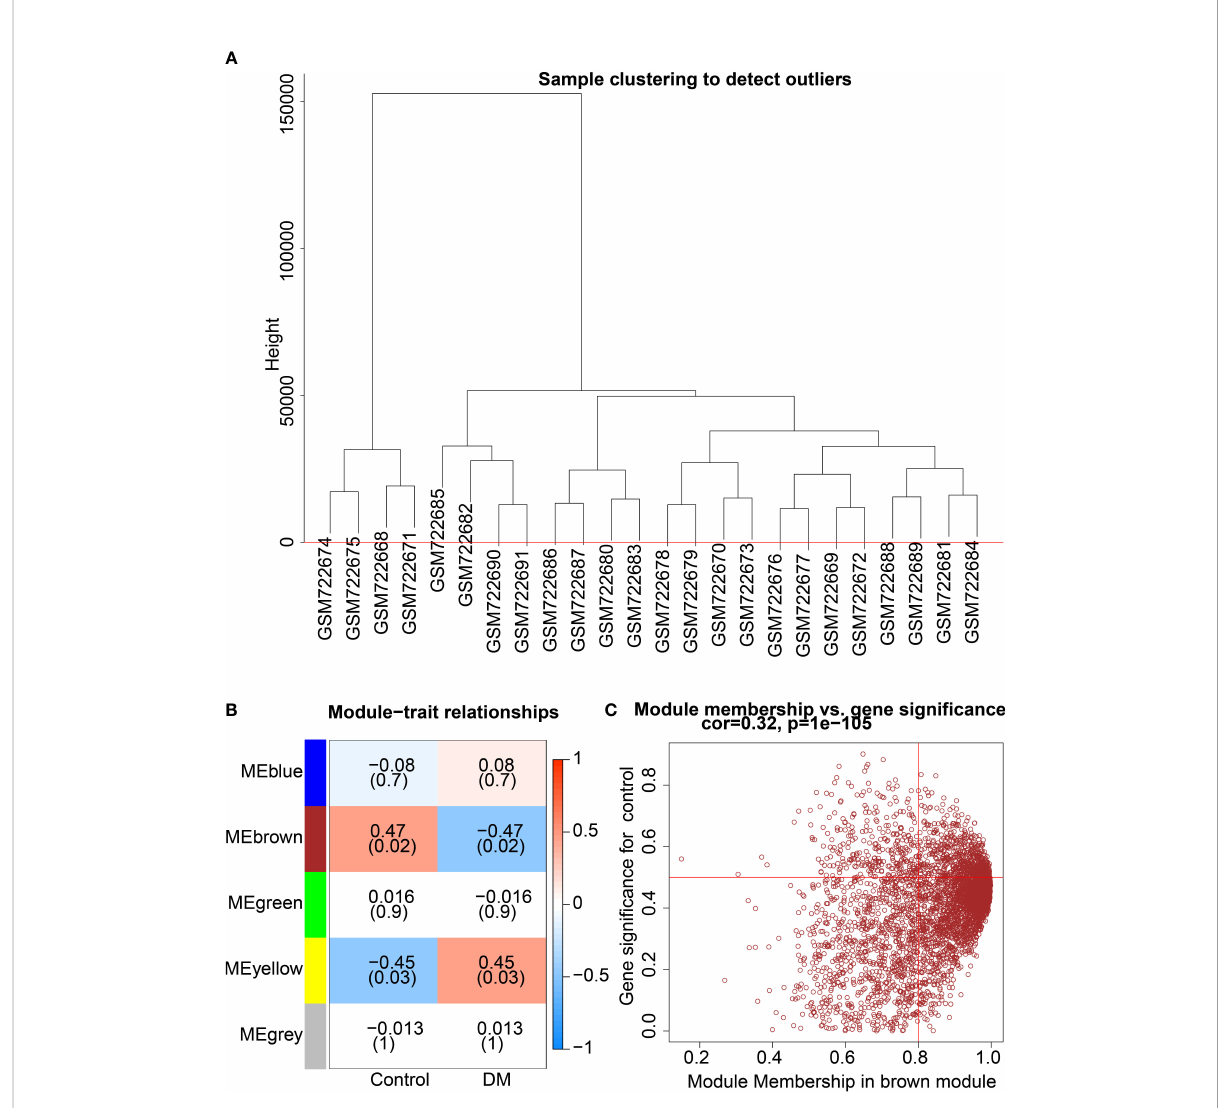
FIGURE 2 Screening of key co-expression module for DM-related genes. (A) , Clustering analysis according to correlation between modules to obtain expression cluster analysis diagram between modules. (B) , Correlation heat map between modules and traits in DM; each cell contains corresponding correlation and p value. (C) , Module correlation diagram of the brown